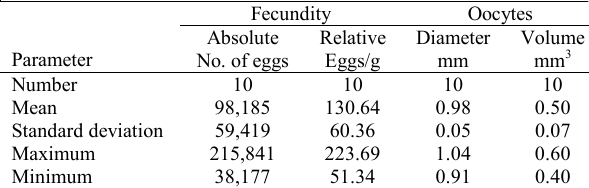
Fig. 5. Monthly Tocantins River water level (m) variation. Verti- cal bars = minimum and maximum values; point = mean